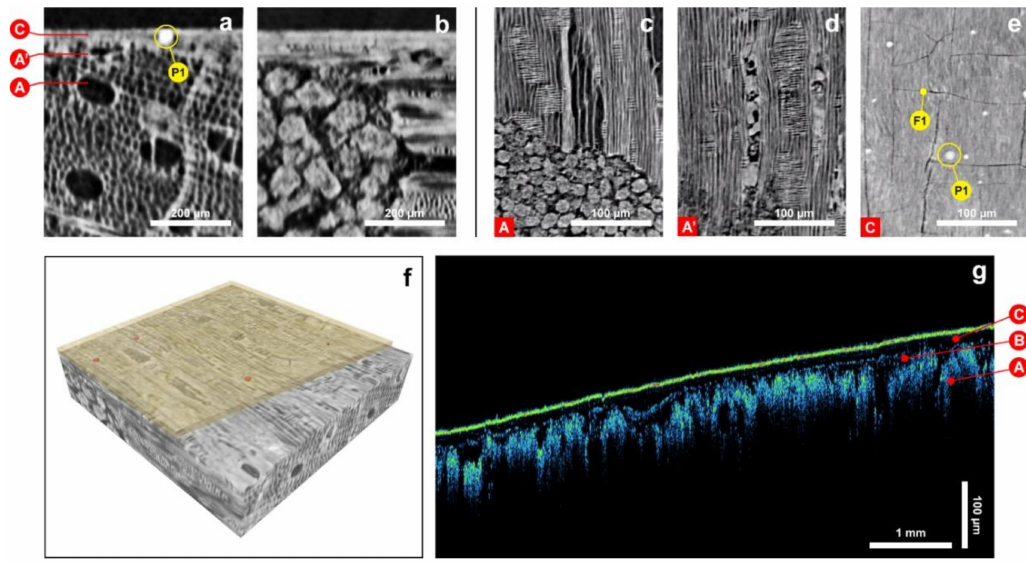
Figure 6. Fragment F20, Giovanni Paolo Maggini. ( a , b ) Transverse and tangential slices from the SR-micro-CT volume showing the particles P1 embedded in the finishing layers. Signs of previous infestation by woodworms are visible in ( a ). ( c – e ) Radial slices from the SR-micro-CT volume showing the finishing layers discussed in the text. Particles and cracks are indicated as P1 and F1, respectively. Signs of woodworms are visible in ( c ). ( f ) Virtual reconstruction based on SR-micro-CT volume. The varnish (layer C in Figure 6a) is colored in yellow and particles in red. ( g ) OCT tomogram presented in false-color scale (see Section 2.2 for details). The wood substrate A, the preparation layer B, and the varnish layer C are